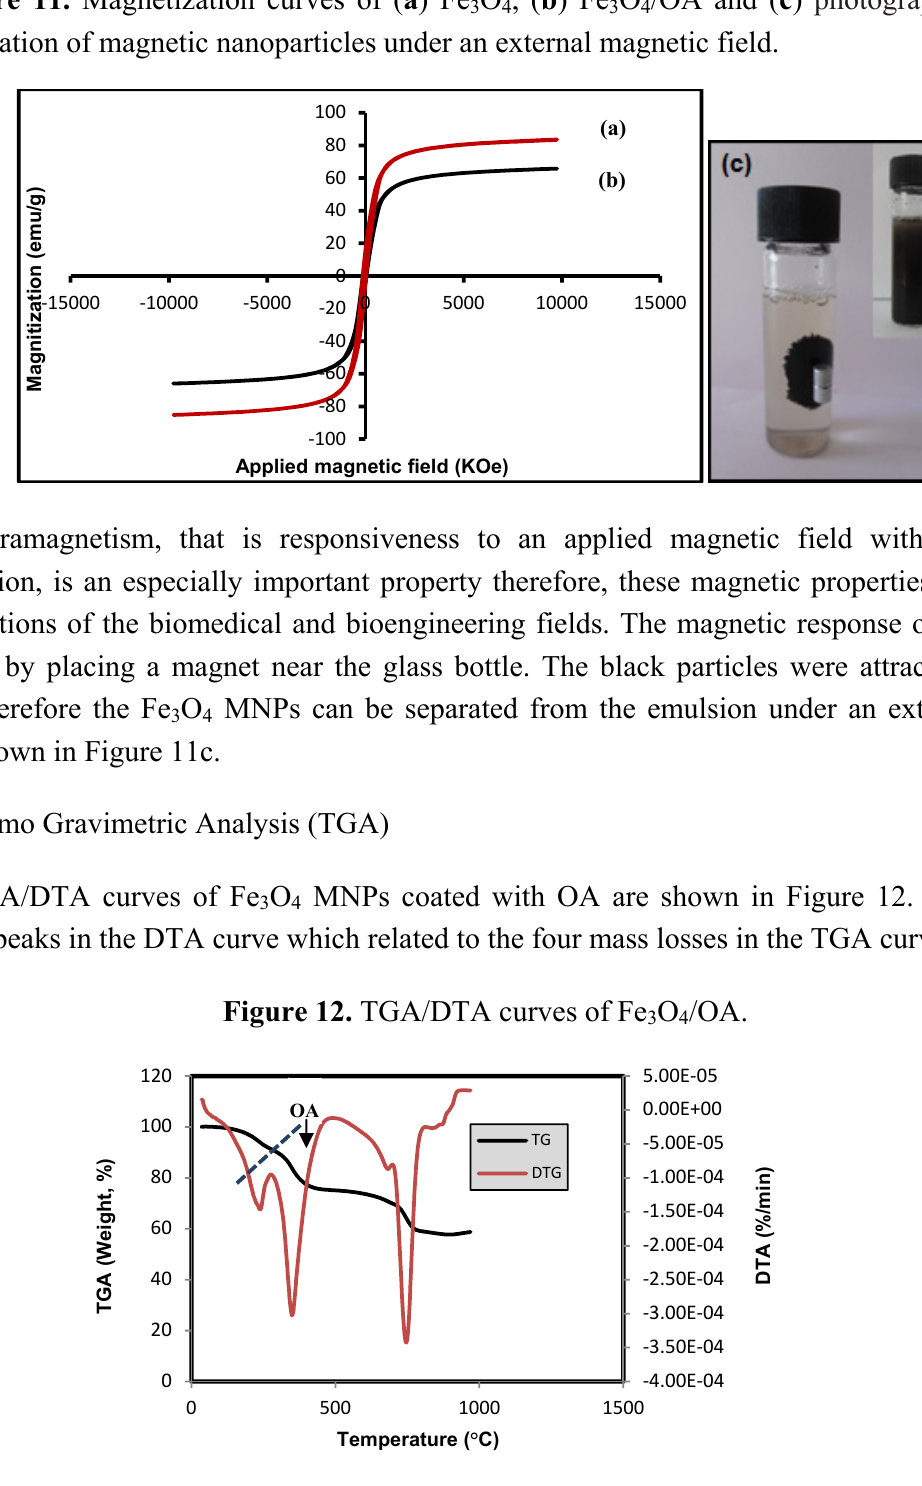
O , ( b ) Fe O /OA and ( c ) photograph of the 3 4 3 4